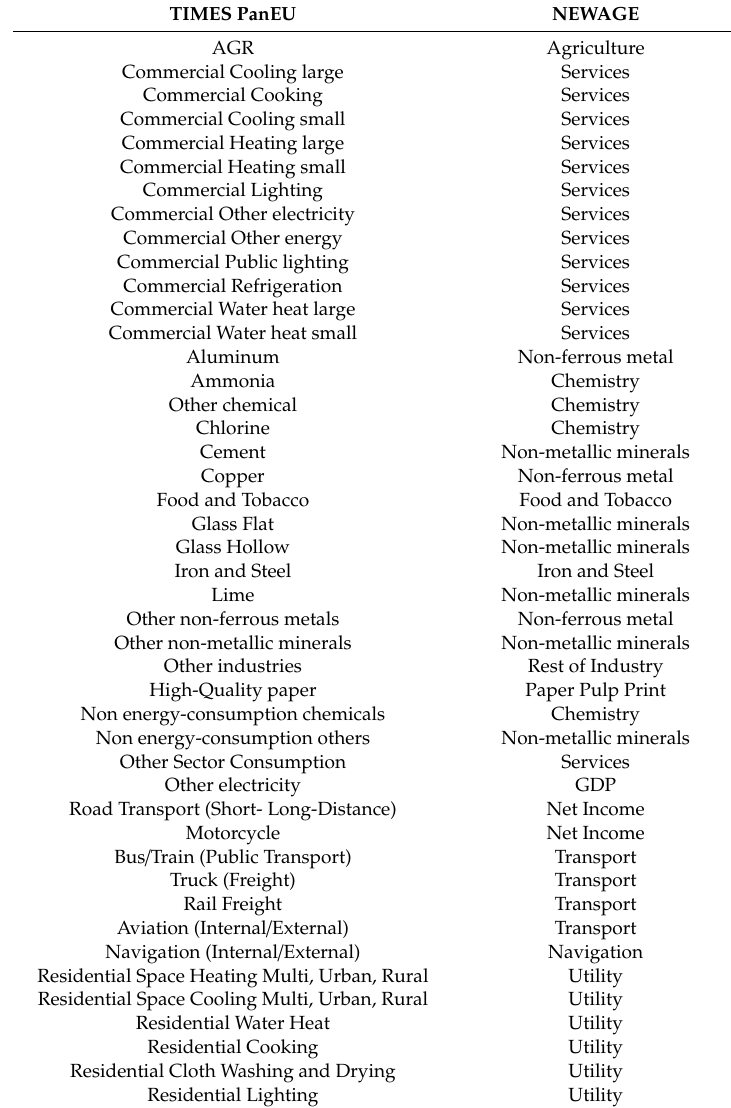
Table A3. The sectoral match between TIMES PanEU and NEWAGE.